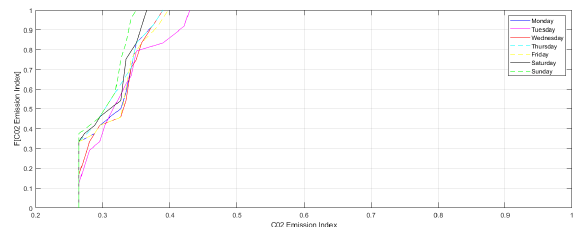
Figure 7: Cumulative distribution function of CO 2 emission in- dex in 2019